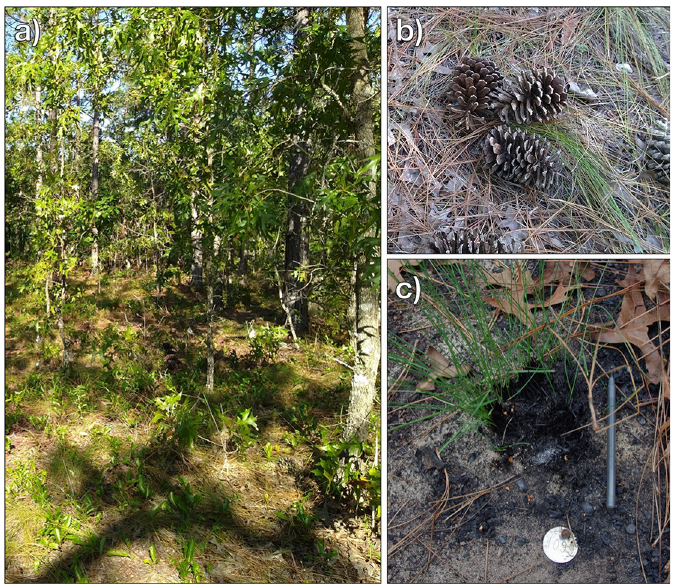
Fig 1. Study system and treatments. Wiregrass a) in the understory of a long unburned xeric pine savanna with an overstory dominated by longleaf pine and turkey oaks; b) under three pinecones for the low duff plus added pinecones treatment (LD + P); and c) after the reintroduction fire, with a portion of the plant resprouting (pen placed for size reference).